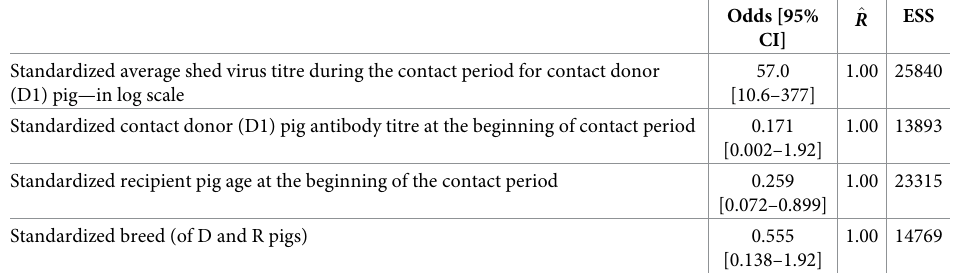
^ R ESS Odds [95% CI] 1.00 25840